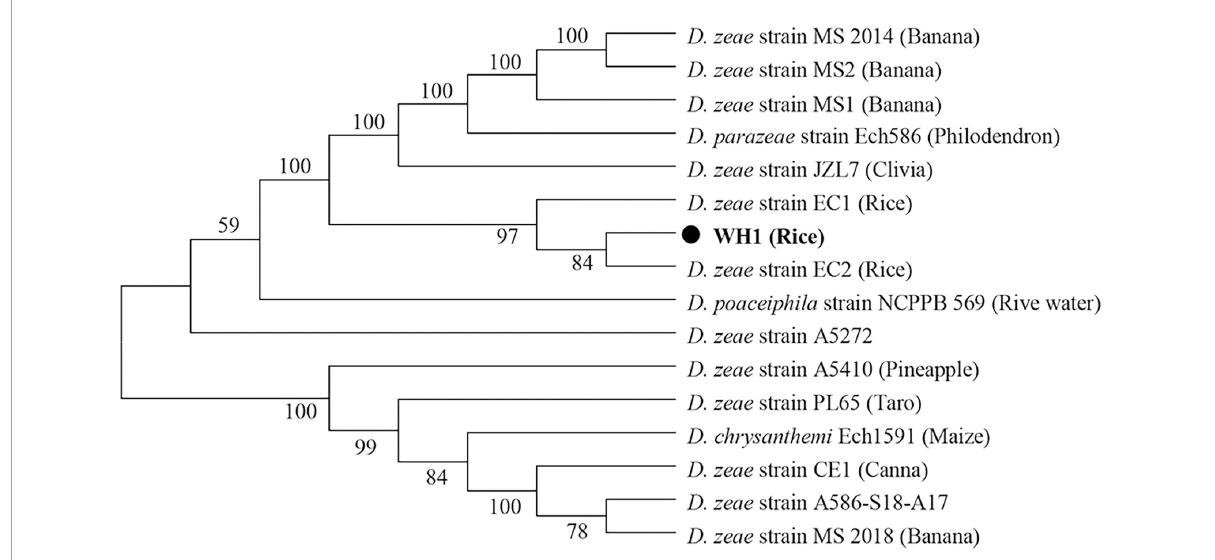
FIGURE1 Phylogenetic placement of Dickeya zeae strain WH1. Phylogenetic analysis of Dickeya s trains based on concatenated sequences of housekeeping genes, apt D, gyr B, inf B, and rpo B, 16 Dickeya strains with complete genomes were included in a phylogenetic analysis with a neighbor joining algorithm and bootstrapped at 1,000